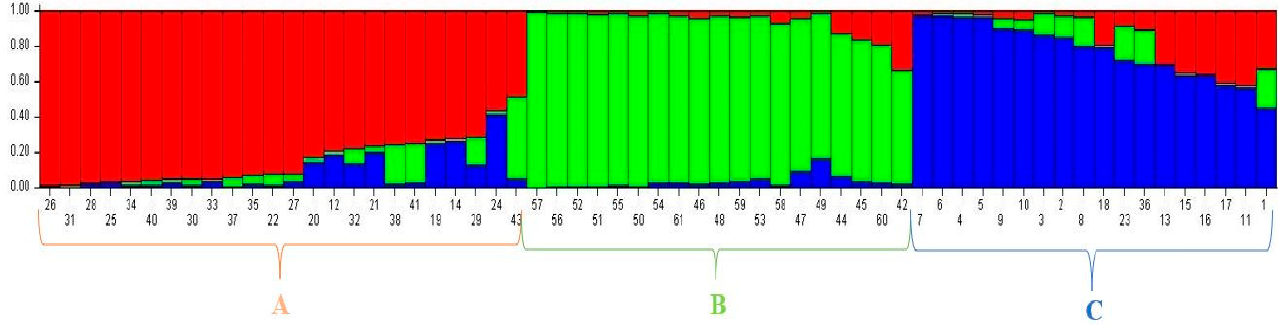
Figure 5. The population structure pattern for the highest Δ K value, K = 3, of 61 forage pea ( P. sa- ( P. sativum ssp. arvense L.) landrace accessions based on 28 SSR tivum ssp. arvense L.) landrace accessions based on 28 SSR markers. Table 6. Heterozygosity and Fst values of forage pea ( P. sativum ssp. arvense L.) landrace accession sub-populations.